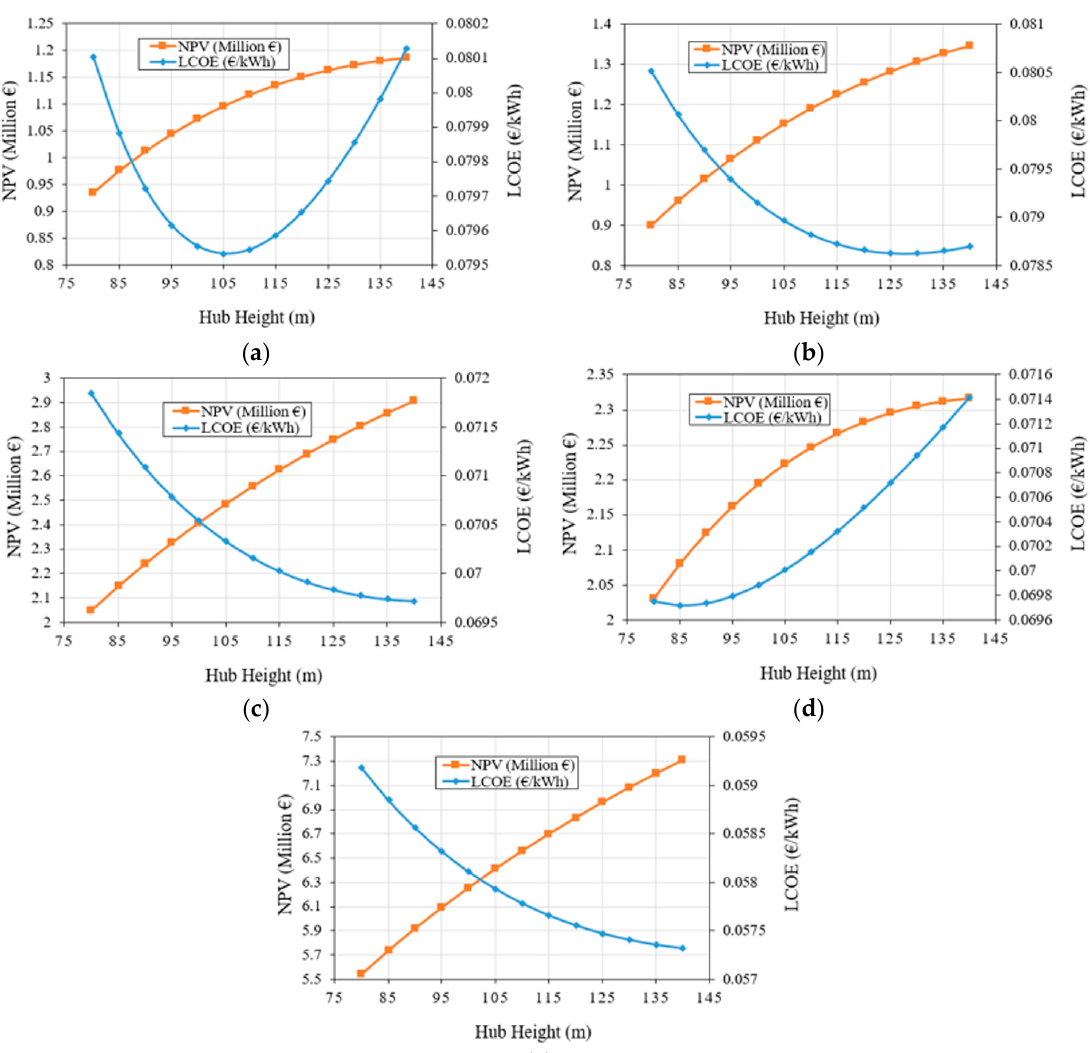
Figure 12. Effect of hub height on wind turbines economics at discount rate of 5% for Baengnyeong-do ( a ) STX 93/2000; ( b ) U 93E/2000; ( c ) U 113/2300; ( d ) HQ 93/2000; ( e ) WinDS 134/3000.